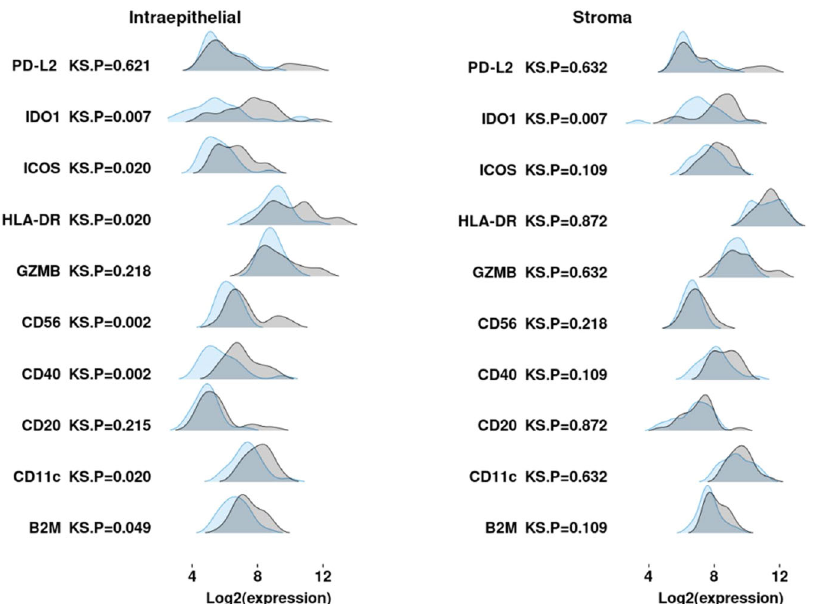
Fig. 1 | Distribution of key immune proteins in intraepithelial and stromal segments as a function of recurrence. Distribution of tumor-average log2 trans- formed normalized counts from 10 immune proteins (differentially expressed at BYadj p <0.05) for both intraepithelial and stromal segments from FinXX samples. Tumors that did not recur (RFS=YES, n =22) are shown in light gray,